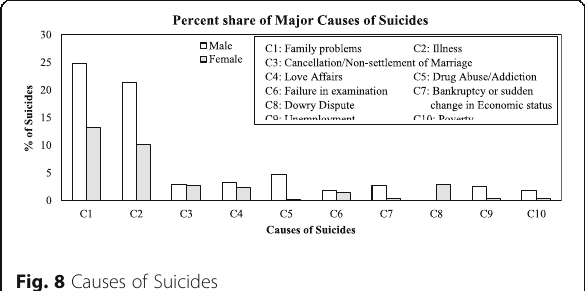
Fig. 8 Causes of Suicides